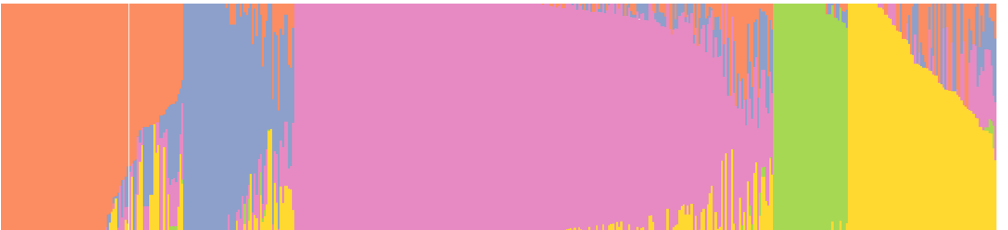
Figure 2. Five subpopulations revealed by fastStructure software resulting from 14,015 SNP markers and 496 barley germplasms. Table 1. The population types were distributed into five subpopulations.